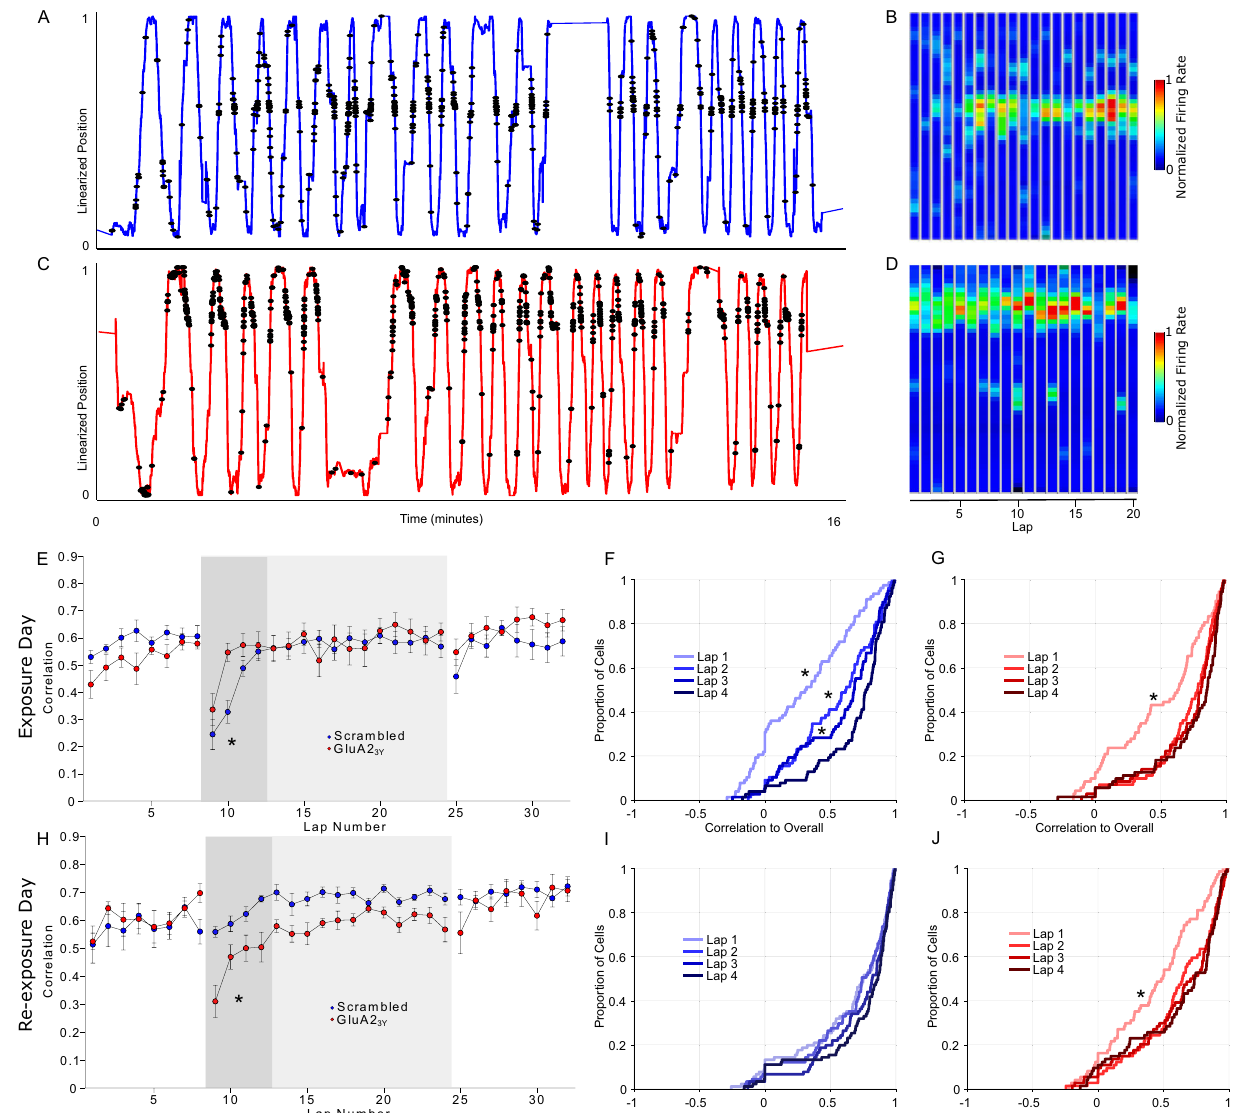
Fig. 4 Blocking AMPA receptor endocytosis acutely alters place fi eld formation dynamics. A – D Linearized position and spike locations for one example cell from a Scrambled treated rat ( A ) and GluA2 3Y treated rat ( C ) and the lap-by-lap fi ring fi eld ( B , D ) upon fi rst exposure to a novel environment. Faster fi eld formation was apparent in GluA2 μ mol/kg IV) prior 3Y treated rats. E On the exposure day rats were administered GluA2 3Y or Scrambled peptide (2.25 to a baseline exploration of the familiar con fi guration, followed by exploration of a novel con fi guration (gray shading). Place fi elds were highly correlated and similar between groups in the familiar con fi guration ( n = 76 Scrambled in N = 6 rats, n = 60 GluA2 3Y in N = 6 rats), but were lower in the fi rst several laps of a novel con fi guration (dark gray shading). Cells from GluA2 3Y treated rats were highly correlated by the second lap, relative to Scrambled peptide treated rats (Scrambled n = 76 baseline, n = 78 novel from N = 6 rats; GluA2 3Y n = 60 baseline, n = 72 novel from N = 6 rats). F The cumulative distribution of correlations on the fi rst four laps developed progressively over four trials in Scrambled treated rats. G Highly correlated fi elds were established after a single lap in GluA2 3Y peptide treated rats. H Rats previously administered GluA2 3Y peptide (red) or Scrambled peptide (blue) were re- exposed to the novel environment (gray shading) after baseline exploration of the familiar environment. Lap by lap correlations were high in the familiar con fi guration in both groups, however only rats previously treated with Scrambled peptide showed highly correlated fi elds in the early laps on the previously novel environment (Scrambled n = 80 baseline, n = 91 novel from N = 6 rats; GluA2 3Y n = 67 baseline, n = 74 novel from N = 6 rats). I Cumulative distribution of correlations over the fi rst four laps showed highly correlated fi eld on re-exposure in Scrambled peptide treated rats. J Re-exposure in GluA2 3Y treated rats showed evidence of consolidation over early laps. In contrast, correlations developed over several laps in rats treated with GluA2 3Y peptide, reminiscent of the initial exposure to the environment in control rats. * indicates p < 0.05 follow-up t -test (two-way) comparison after signi fi cant lap by group ANOVA interaction, and p < 0.05 ks-test vs lap 4 distribution. Error bars represent ± on impaired inhibitory avoidance was recapitulated with fEPSP reduction speci fi cally in synapses to apical dendrites of hippocampus-speci fi c inhibition of AMPA receptor endocytosis, CA1 neurons in response to novelty exposure in the absence of our evidence suggests that mechanisms supporting LTD in the changes in synapses targeting the basal dendrites of CA1 in the hippocampus are engaged during novel environment exposure to stratum oriens suggest an effect independent of global alterations establish stable place fi eld formation and memory. De novo such as brain state or temperature changes previously implicated